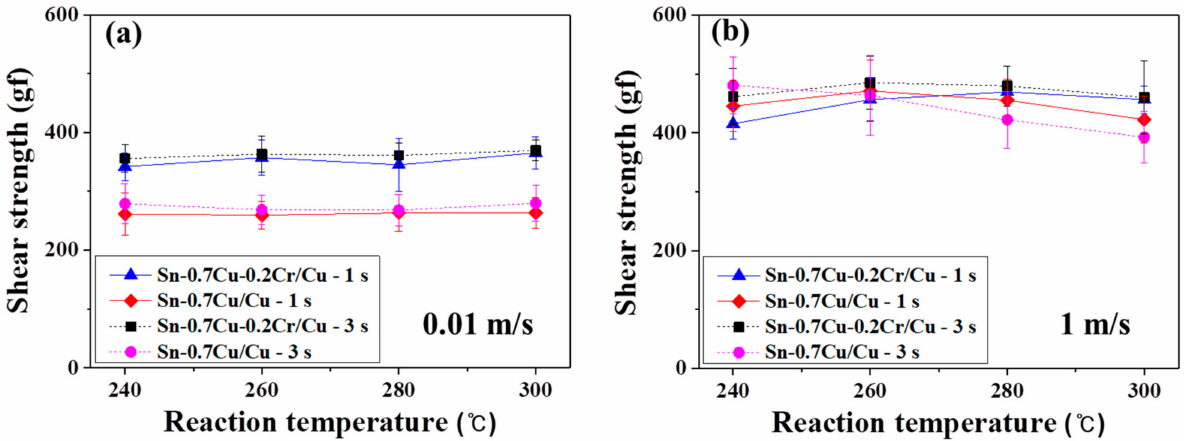
Figure 12. Shear strength of the solder joints at shear speeds of ( a ) 0.01 and ( b ) 1 m/s under various reaction